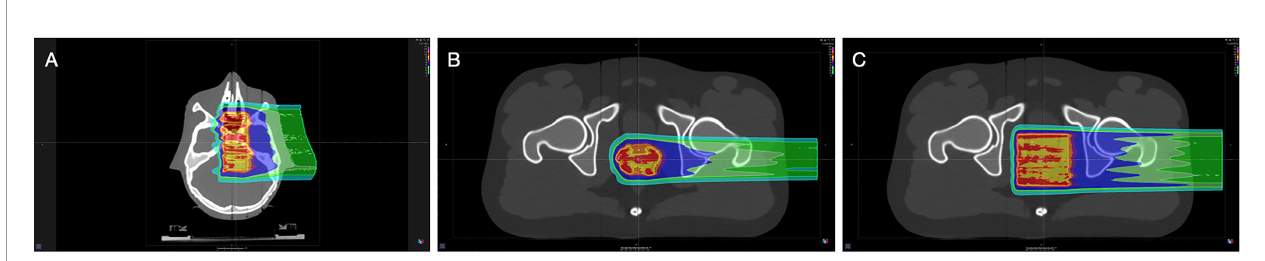
FIGURE 2 | Proton therapy treatment plans designed with the RayStation Treatment Planning System. (A) Head phantom with an 8 x 8 x 3 cm 3 target volume, (B) pelvic phantom with a prostate-like target volume of 52 cm 3 , (C) pelvic phantom with a 6 x 6 x 6 cm 3